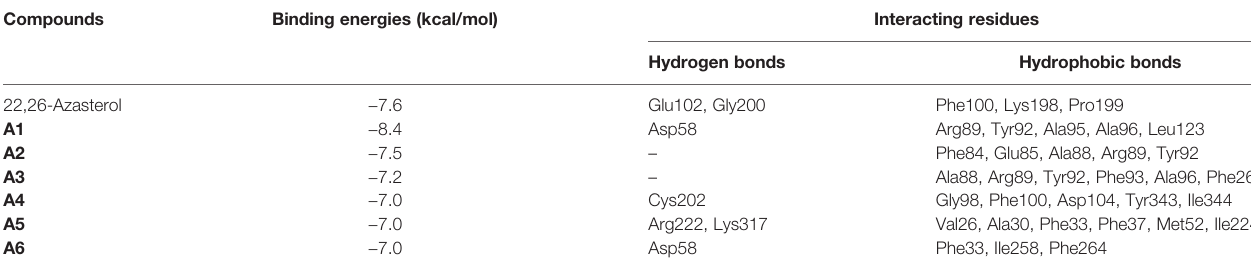
TABLE 2 | Binding energies and predicted interacting residues in the Ld SMT – hit complexes. Compounds